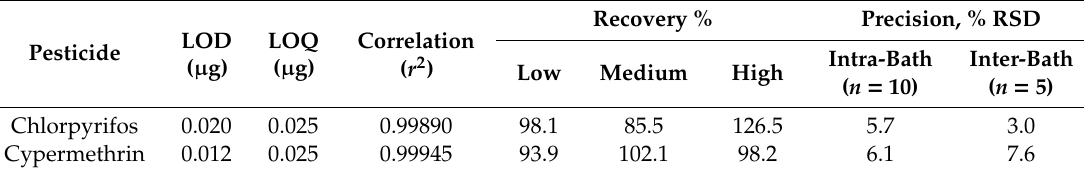
Table 1. Quality control for insecticide